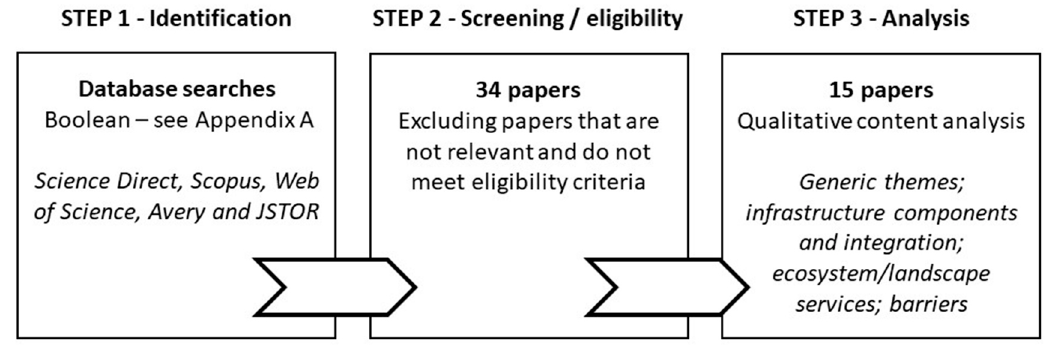
Figure 2. Diagrammatical representation of systematic literature review process.